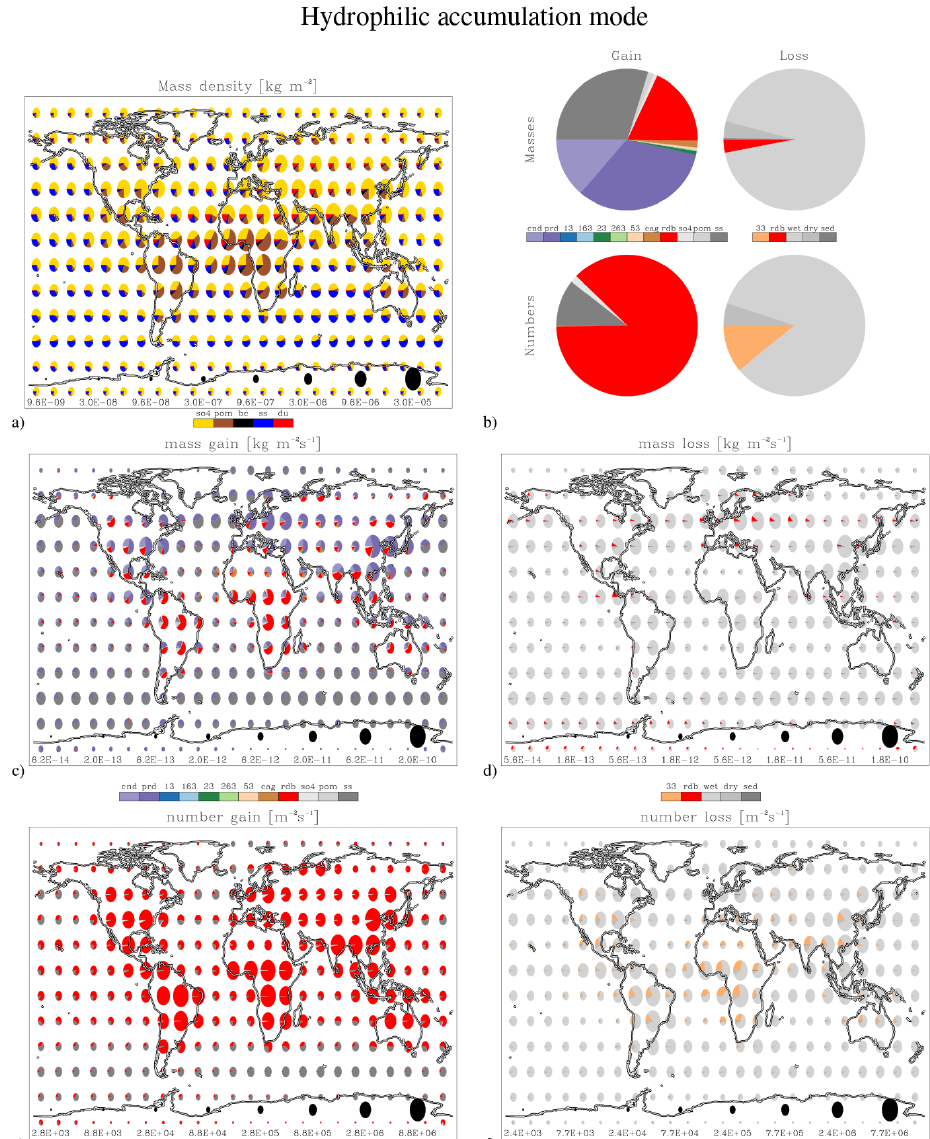
Figure 15. Global distribution of annual burdens (a) and tendencies ( b, c, d, e and f ) of the hydrophilic accumulation mode. The colors indicate either species (defined in Table 3) or processes (defined in Table 2). The pie chart shows fractional contributions, while the radius of the pie indicates total column burden or total column tendency (logarithmic scale as shown in black at the bottom of panels a, c, d, e and f ). Panel b shows a global average of the